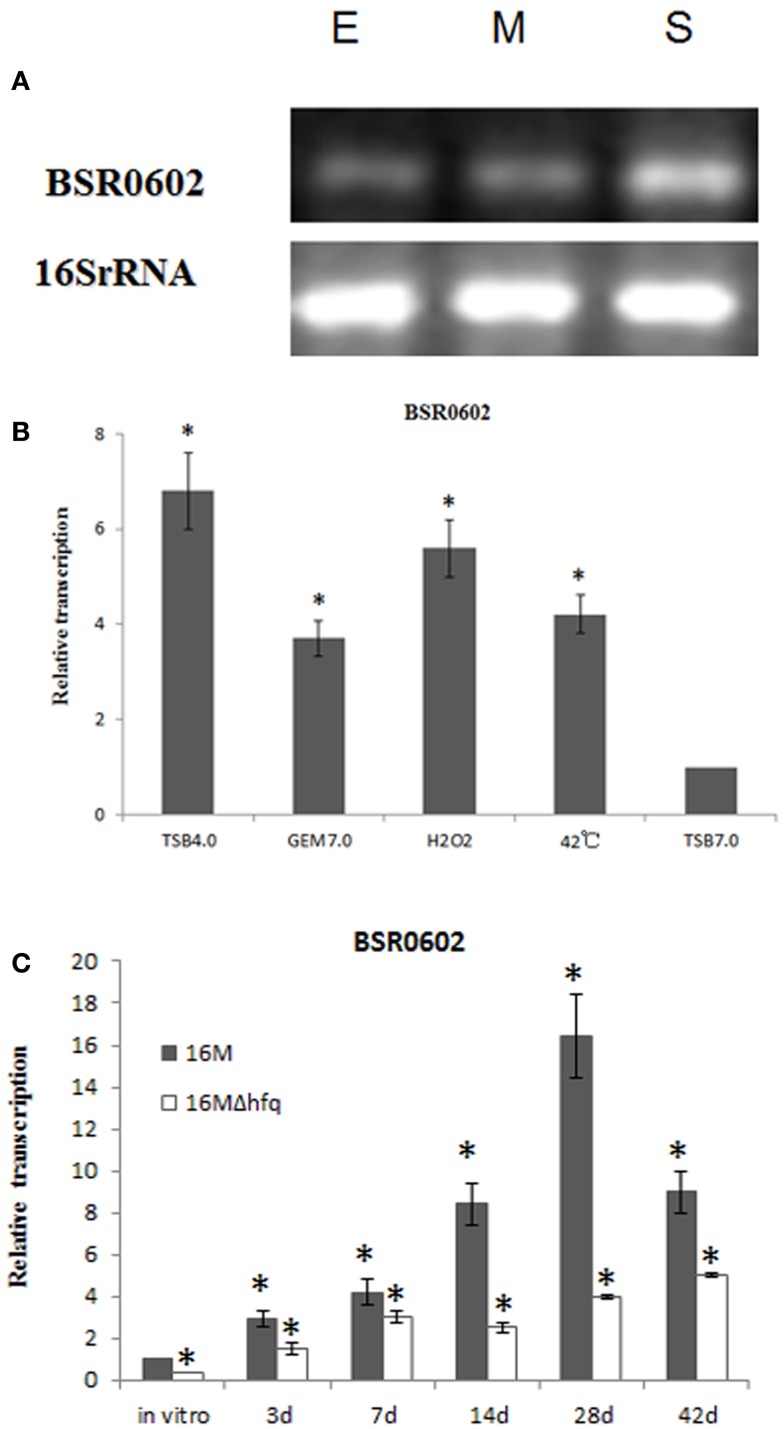
BSR0602 is expressed under infection related conditions. (A) Growth dependent expression of BSR0602. Total RNA was extracted from B. melitensis 16M grown in TSB to early-exponential stage (E), mid-exponential stage (M), and early stationary phase (S). RNA was isolated and transcription of BSR0602 was quantified by semi-quantitative RT-PCR. The 16S rRNA was used as an internal control. (B) Expression of BSR0602 in vitro environmental stresses. 16M was firstly cultured in TSB (pH7.0) and then subjected to different in vitro environment stresses. RNA was isolated and transcription of BSR0602 was quantified by qRT-PCR. The values of the relative expression, which are the means from triplicate experiments, represent the ratios of the levels of BSR0602 under different in vitro stresses to that under the regular TSB7.0 condition. Asterisks (*) represent significant differences compared with that under TSB7.0. (C) Expression of BSR0602 during mouse infection. BALB/c mice (five per time point) were intraperitoneally infected with B. melitensis 16M and 16MΔhfq, and then the intracellular bacteria were recovered from the spleens at 3, 7, 14, 28, and 42 days post infection, respectively. Total RNA was isolated and subjected to qRT-PCR as described. The values represent the relative level of BSR0602 in 16M or 16MΔhfq recovered from the spleen as compared to the level of BSR0602 in B. melitensis grown to exponential phase in vitro. The asterisks above gray box denote values significantly different from those of in vitro condition, and asterisks above white box represent significant differences between 16M and 16MΔhfq.